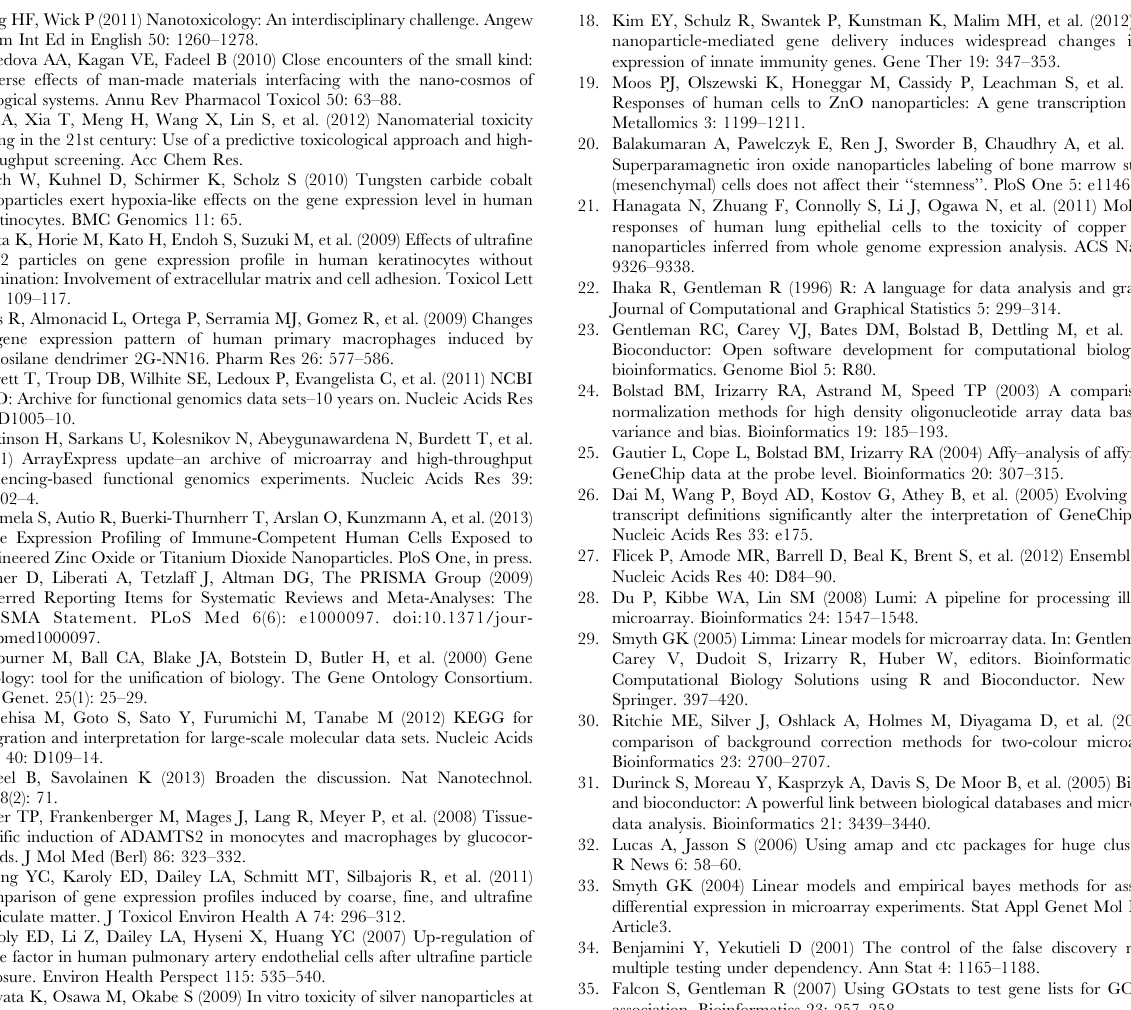
Table S6 The adjusted p-values of the gene-wise differential expression analysis for the genes within the GO:0006955: immune response. The value is marked in red, if the adjusted p-value # 0.05 and the absolute fold change between the treated and control sample value $